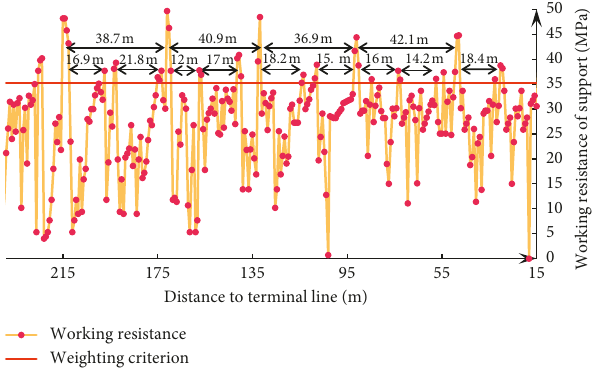
Figure 4: Working resistance curve of the support.